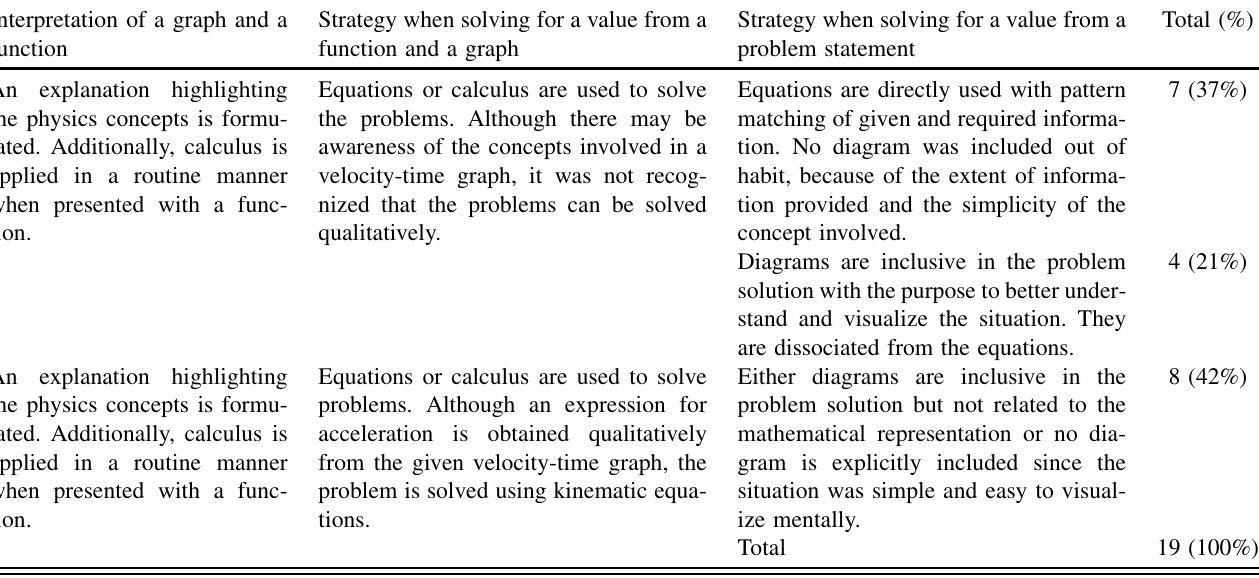
Diagrams dissociated from equations Diagrams related to equations